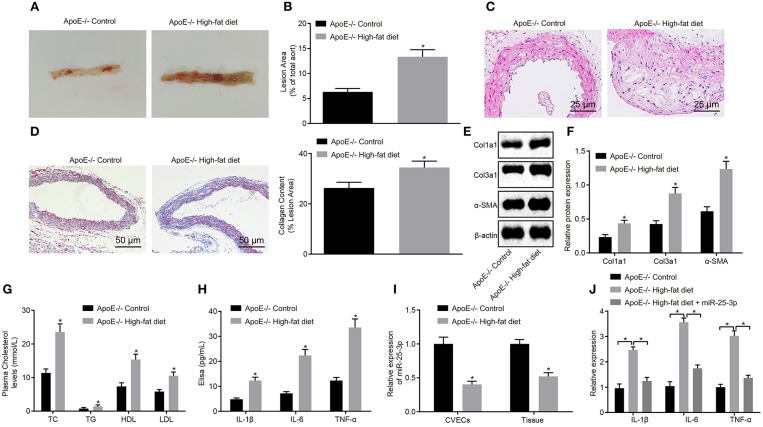
MiR-25-3p exhibits a low expression in vascular tissues of atherosclerosis models of ApoE−/− mice. (A,B) Oil red O staining and quantitative analysis of aorta (Scale bar = 5 mm). (C) HE staining results of aorta slices (Scale bar = 25 μm). (D) Masson staining of aorta slices (Scale bar = 50 μm). (E,F) Protein levels and bands of α-SMA, Col1a1 and Col3a1, as measured by Western blot analysis. (G) Levels of TG and TC determined by ELISA; (H) levels of IL-1β, IL-6, and TNF-α in atherosclerotic tissues, as determined by ELISA. (I) miR-25-3p expression in CVECs from control ApoE−/− mice and ApoE−/− mice treated with high-fat diet, as determined by RT-qPCR. (J) Levels of IL-1β, IL-6, and TNF-α in CVECs from control ApoE−/− mice and ApoE−/− mice treated with a high-fat diet and transfected with miR-25-3p mimic, as determined by RT-qPCR. *p < 0.05 vs. the ApoE−/− control group (control ApoE−/− mice). All data are measurement data and expressed as mean ± standard deviation, and data between two groups were analyzed using independent sample t-test. n = 7. The experiment was repeated three times independently.